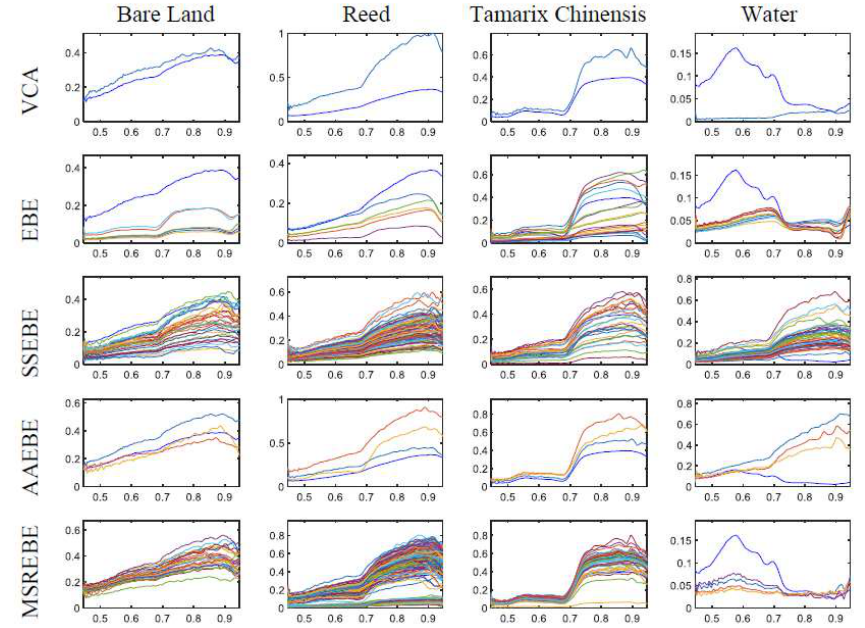
Figure 9. The endmember extraction results of wetland dataset. Table 2. Experimental results of wetland dataset.